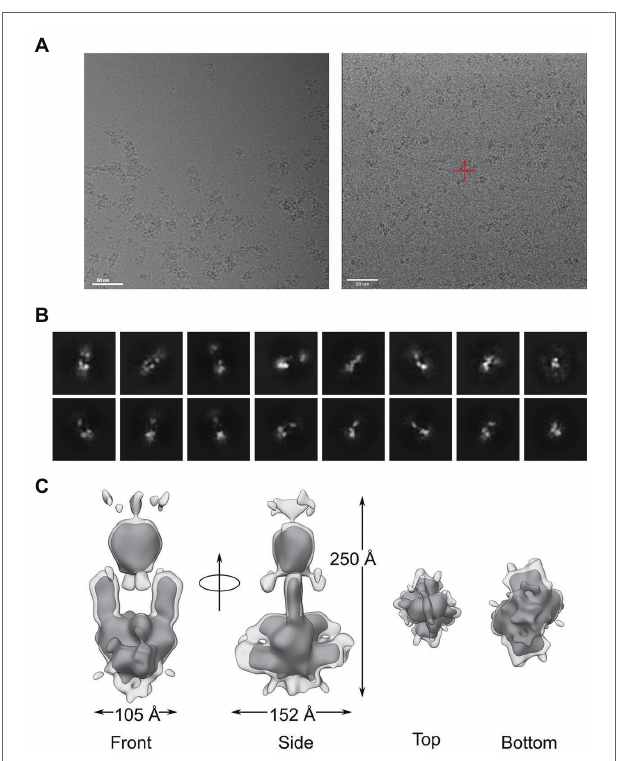
FIGURE 4 | Structural analysis of full-length At phyA by single particle cryo- electron microscopy. (A) Electron micrographs for At phyA prepared at pH 8.0 (left) or pH 9.3 (right). The scale bar indicates a length of 50 nm. (B) Selected reference-free 2D classes of At phyA (top row) in comparison with the reprojections of the 3D cryo-EM model (bottom row). (C) The 3D electron density map at ~17 Å resolution demonstrates a head-to-head dimeric arrangement of At phyA. The light and dark gray densities are contoured at different levels, see main text.